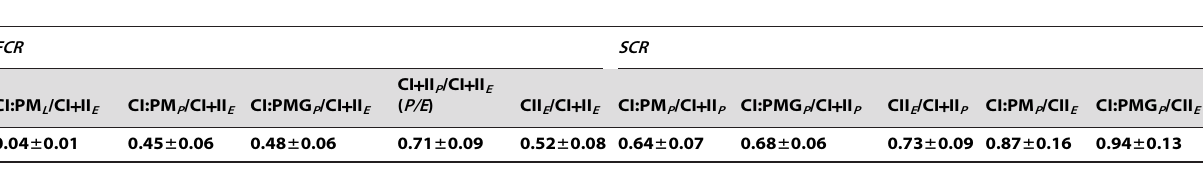
Values are means 6 SD. For abbreviations, see text. doi:10.1371/journal.pone.0034890.t005 PLoS ONE |